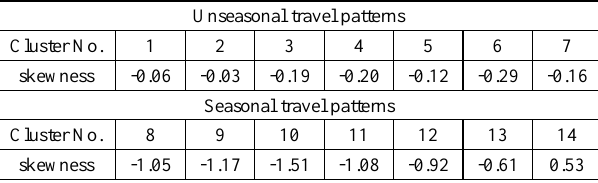
Table 2. The values of skewness of the 14 clusters